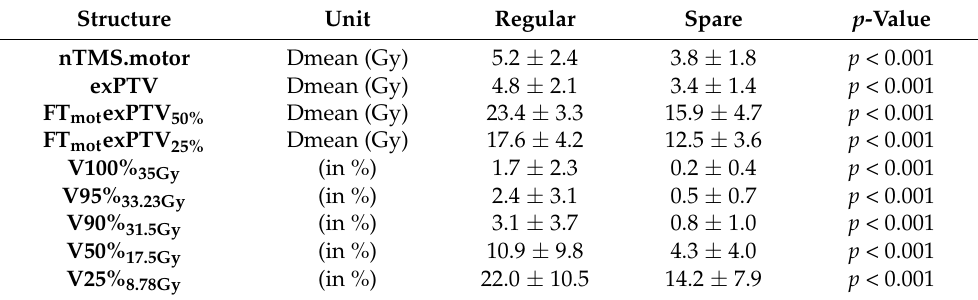
Figure 1. RT plan adaption for avoidance of FT mot.tms translates into decline of proportional overlap, with corresponding isodose levels expressed as V95%, V90%, V50%, and V25% (%), with and without sparing (spare vs. regular). Mean V90% decreased by 74.2% (3.1% to 0.8%) and V50% by 66.8% (10.9% to 4.3%). All results are significant ( p < 0.001). Table 2. Dose exhibition of nTMS derived fiber tract in regular plans (regular), and plans with dose adaption for sparing (spare). Mean dose of the total fiber tract decreased by 1.4 Gy. Segments of the CST beyond the PTV and inside 50%-Isodose-level reduced from 23.4 Gy to 15.9 Gy. Spatial overlap in percent of total volume for different isodose levels and FT mot.tms were described as V100% 35Gy , V95% 33.23Gy , V90% 31.5Gy , V50% 17.5Gy , and V25% 8.78Gy . After plan adaption volumes were significantly lower ( p < 0.001).